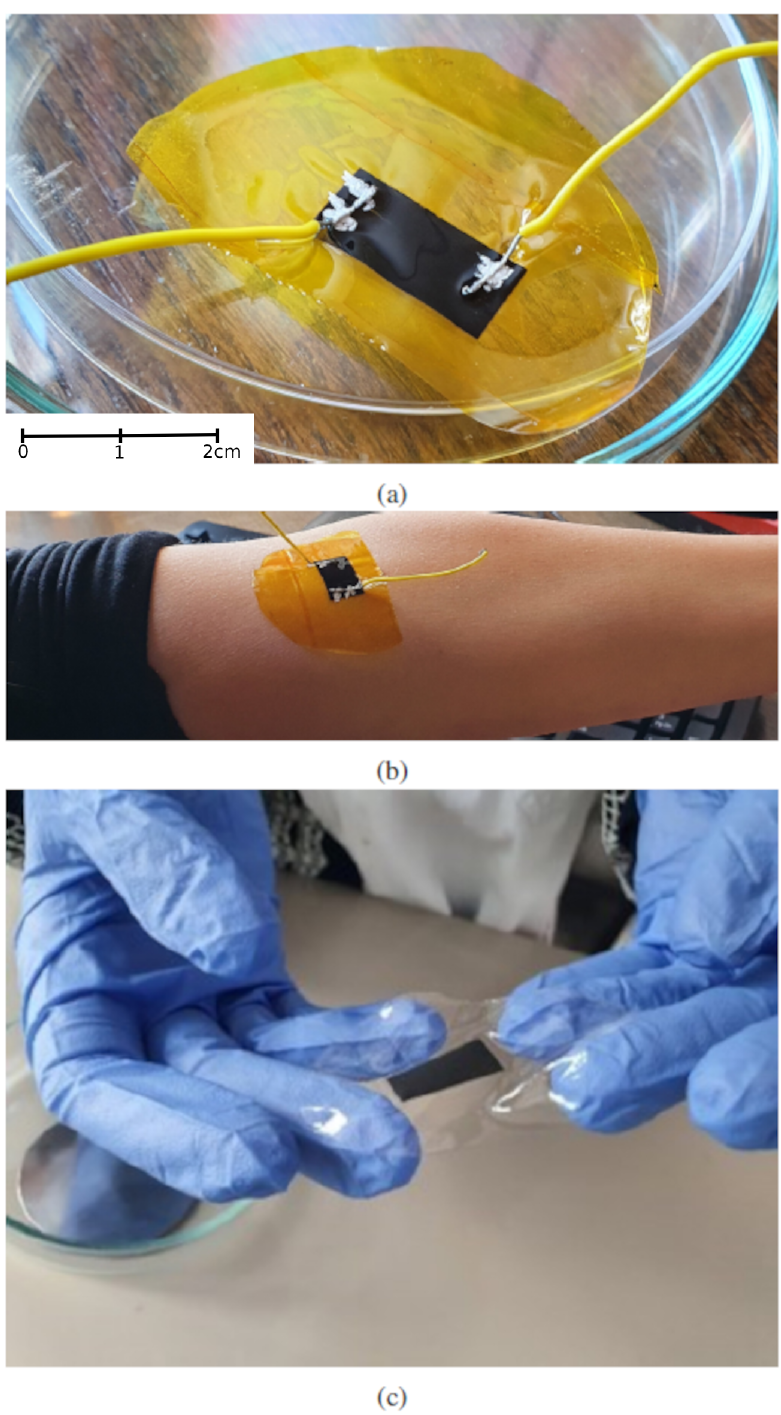
Figure 1. Photographs of the graphene sensors. ( a ) Graphene on a PI substrate, covered with PDMS seen as a glossy top layer, and contacted with two wires at sensor ends. The wires were attached to the graphene with silver paste. ( b ) The sensor with wires on a subject’s forearm, at the position of the median cubital vein. ( c ) Graphene completely transferred to PDMS, with the PI substrate